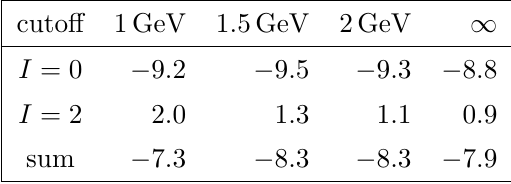
Table 3. Results for the S -wave rescattering contribution to ( g refers to the (cid:12)nite-matching-point analog of (4.13) .